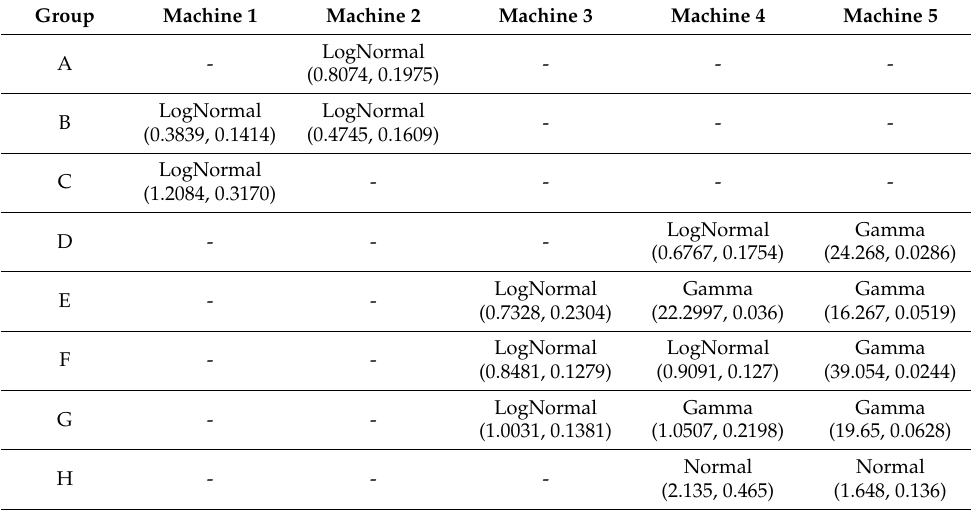
Table 2. Processing time distributions regarding final